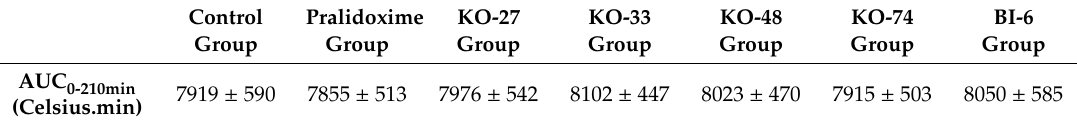
Table 1. Values of area under curve (AUC) from 0 to 210 min for core temperature. Each group consisted of five rats. Data are represented by mean ± S.E.M. at each time after injection. Control Pralidoxime KO-27 KO-33 KO-48 KO-74 BI-6 Group Group Group Group Group Group Group AUC 0-210min 7919 ± 590 7855 ± 513 (Celsius.min)